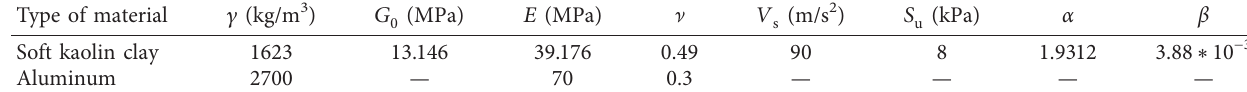
Table 1: Properties of soft clay and aluminum.